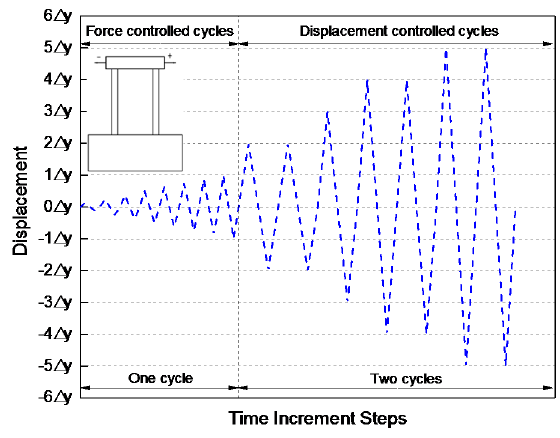
Figure 5. Cyclic Displacement History for Quasi-static Test of Shear Wall Specimens. ∆ y indicates the lateral displacement when the wall specimen shows yielding